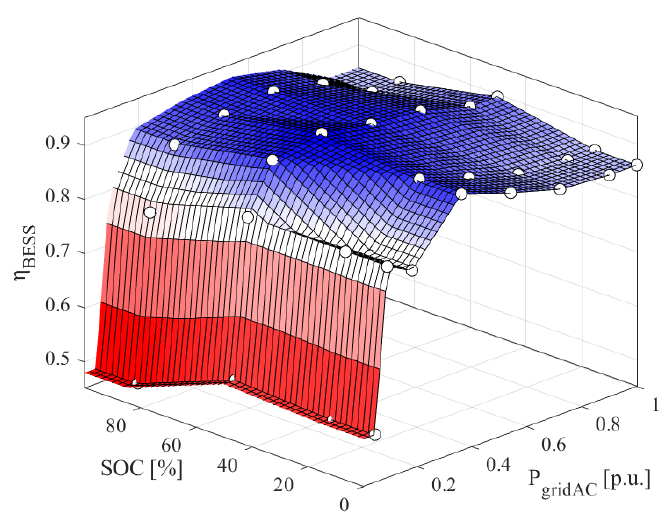
Figure 10. BESS e ffi ciency. Figure 10. BESS efficiency.